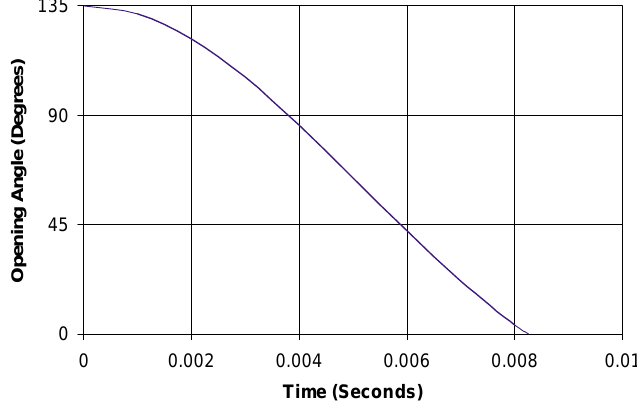
Fig. 11. Fin opening angle as a function of time, zero-yaw, 15.6 Hz spin rate.